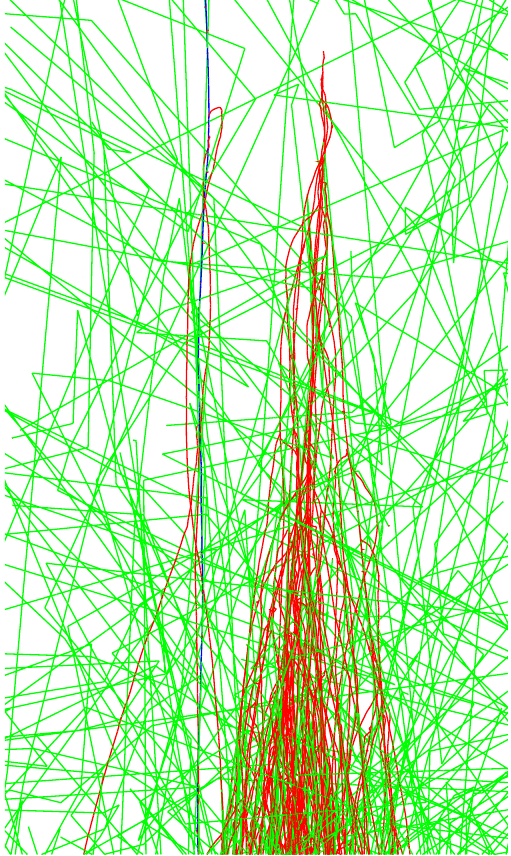
Figure 2: Geant 4 simulation. Red tracks — electrons. Blue tracks — positrons. Green tracks — gamma-rays. Simulation conducted for normal air density and electric field of 10 kV / cm . Left